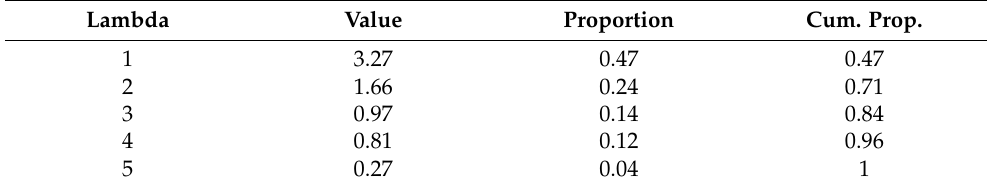
Table 5. PCA eigenvalues obtained with the nutritional quality data of the evaluated plants.